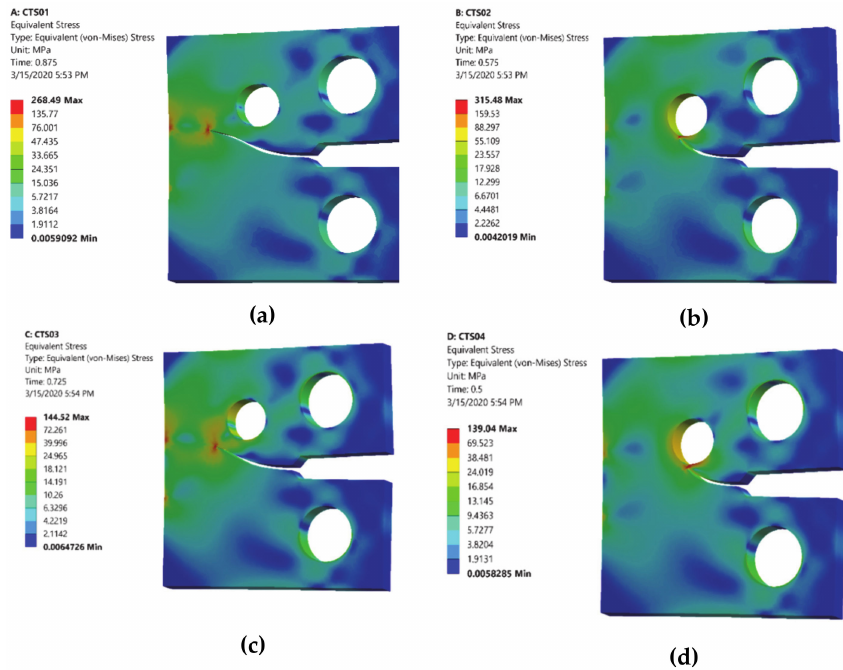
Figure 9. Equivalent Von Mises stress distribution for di ff erent configuration of CTS, ( a ) CT01, ( b ) CT02, ( c ) CT03 and ( d )